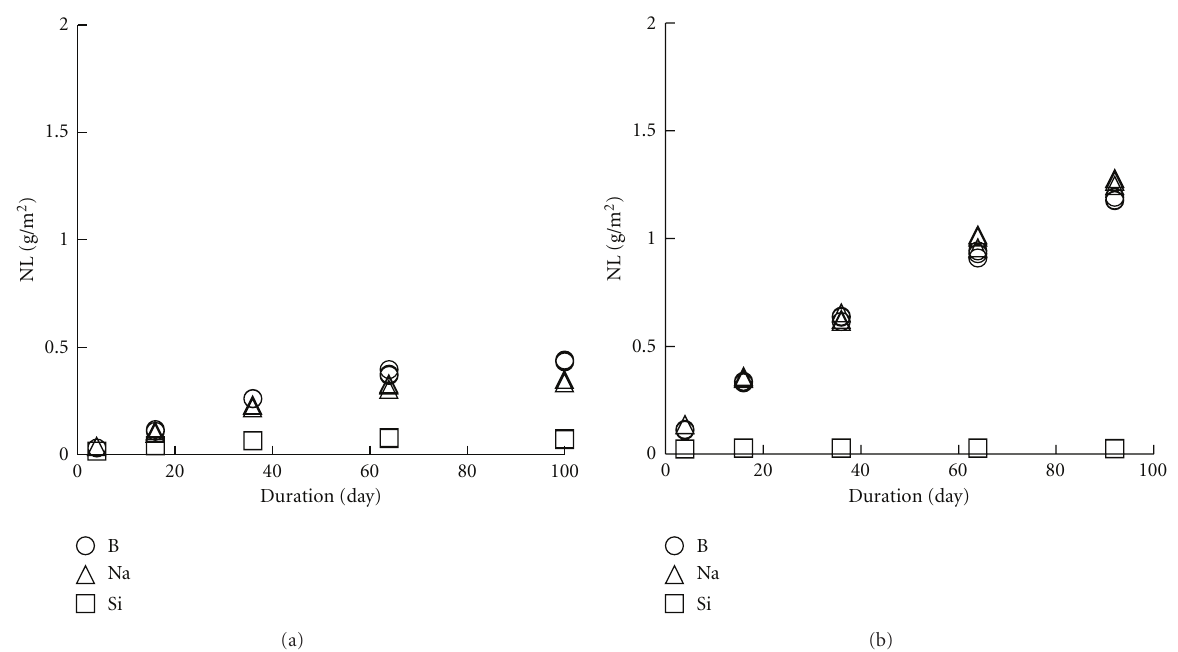
Figure 2: The NL for B, Na, and Si versus time for the tests in (a) DIW and in (b) MgCl 2 solution at 60 ◦ C.